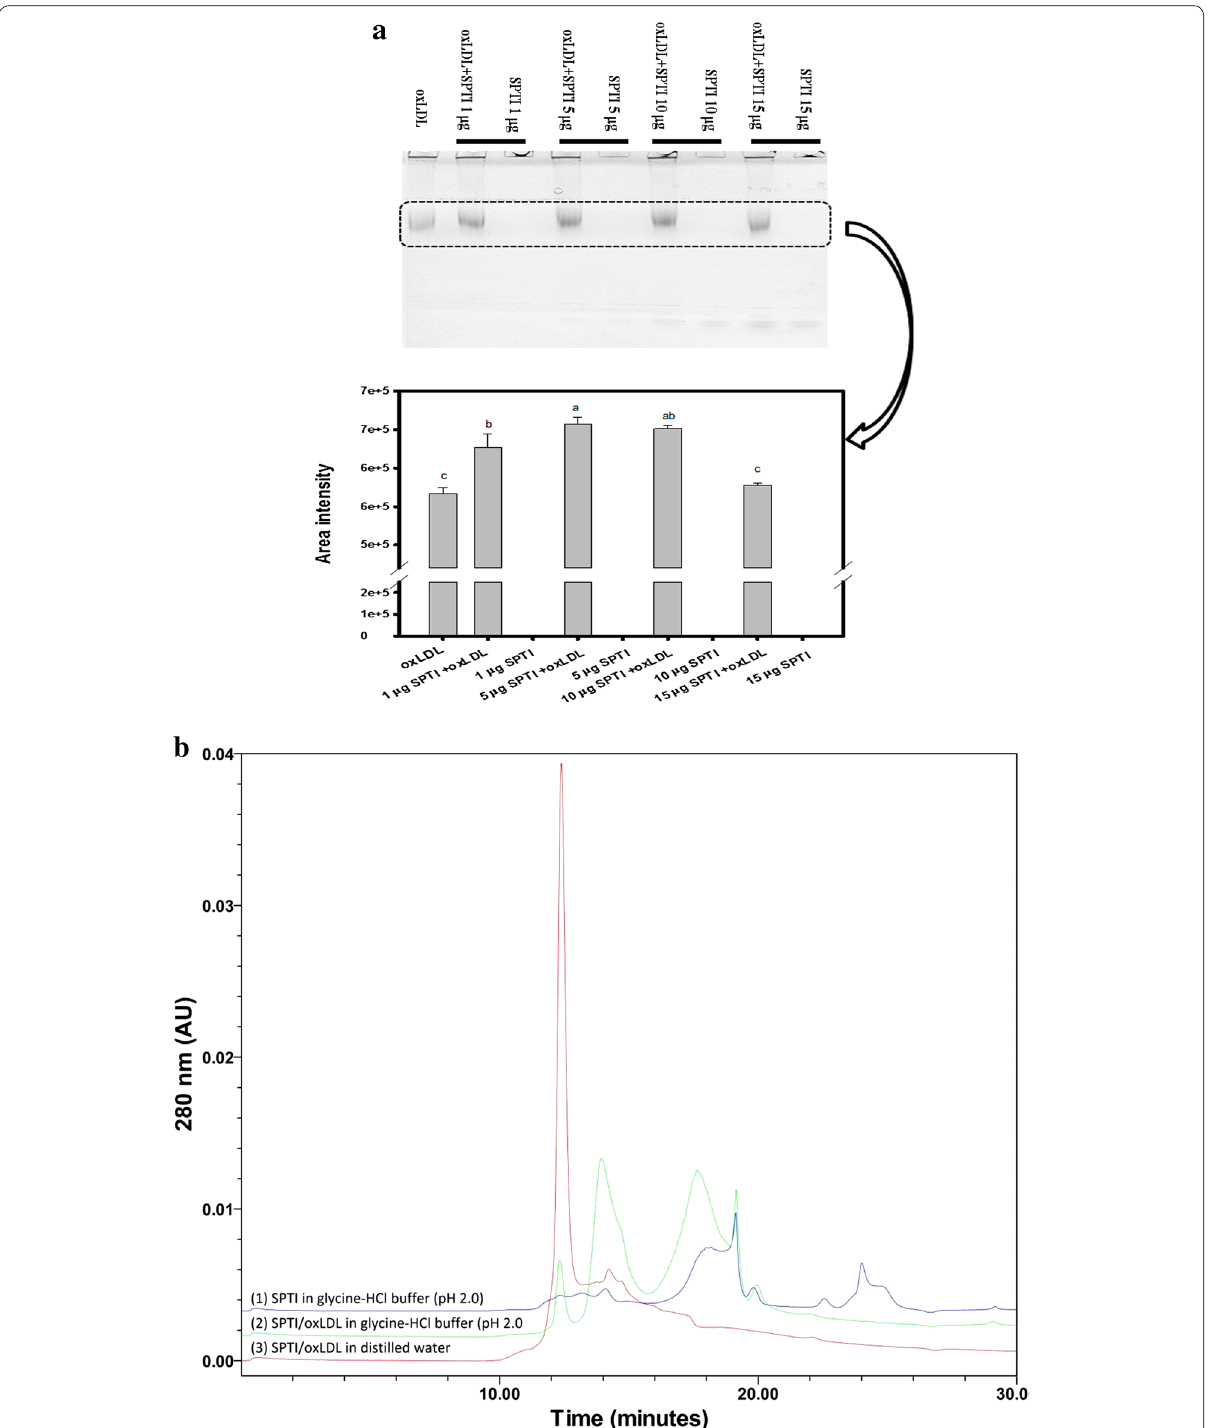
Fig. 2 a Effects of SPTIs on oxLDL binding were evaluated by protein stains in native PAGE gels with two layers of separation gels. The selected square frame was quantified by a Syngene G:bBOX imaging system (Syngene, UK), and b the HPLC equipped with TSKgel G3000PW XL (7.8 300 mm) gel filtration column was used to analyze the molecular size changes of SPTIs/oxLDL complex. (1) The SPTIs alone in glycine–HCl × buffer (pH 2.0, deep blue line); (2) SPTIs/oxLDL binding assays in the glycine–HCl buffer (pH 2.0, green line); (3) SPTIs/oxLDL binding assays in the distilled water (red line). Values were presented as mean SD and were analyzed using one‑way ANOVA, followed by a post hoc Tukey’s test for ± multiple comparisons. The different marked symbols in each bar were significantly different ( P <